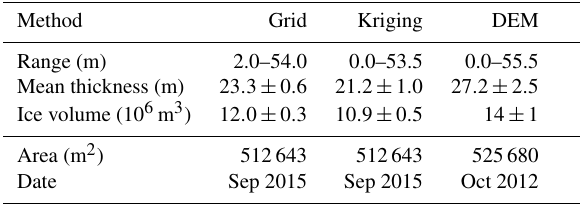
Table 2. Ice thickness derived from spatial interpolation using a combination of GPR and DEM data (“grid”), GPR only (“kriging”) and DEM only (“DEM”). Uncertainties for grid and kriging are es- timated from comparison with unused GPR data points (see text). For the DEM method uncertainties are reported as 1 standard